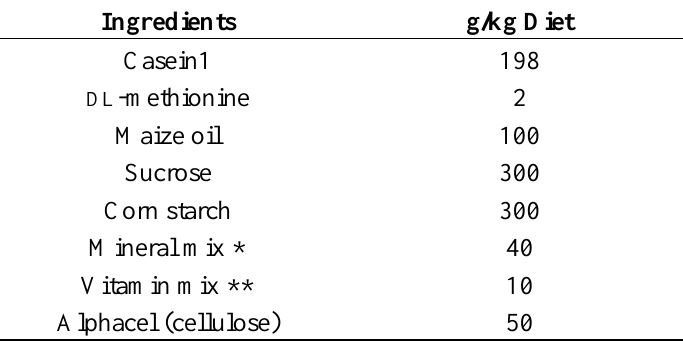
Table 1. Composition of the control diet.